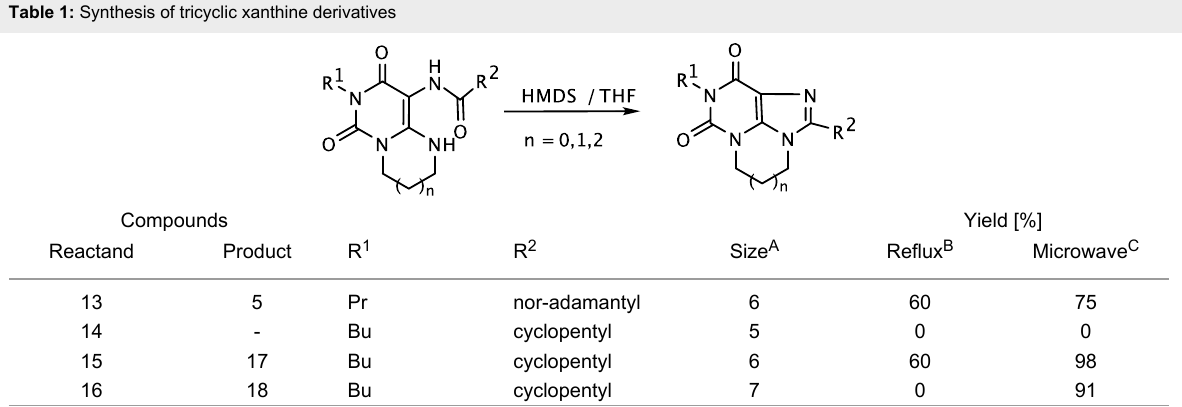
Compounds Reactand